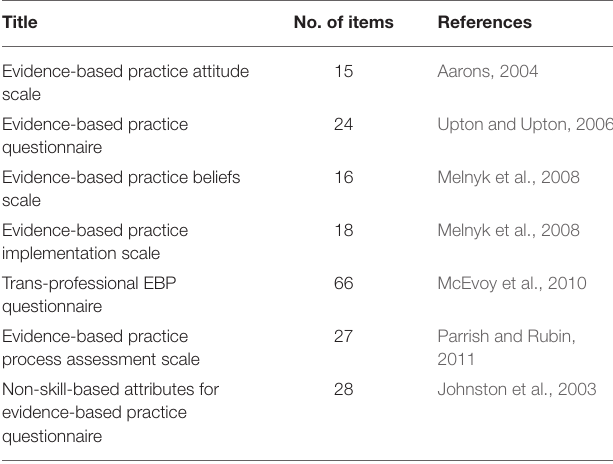
TABLE 1 | Overview of the evidence-based practice scales in medical